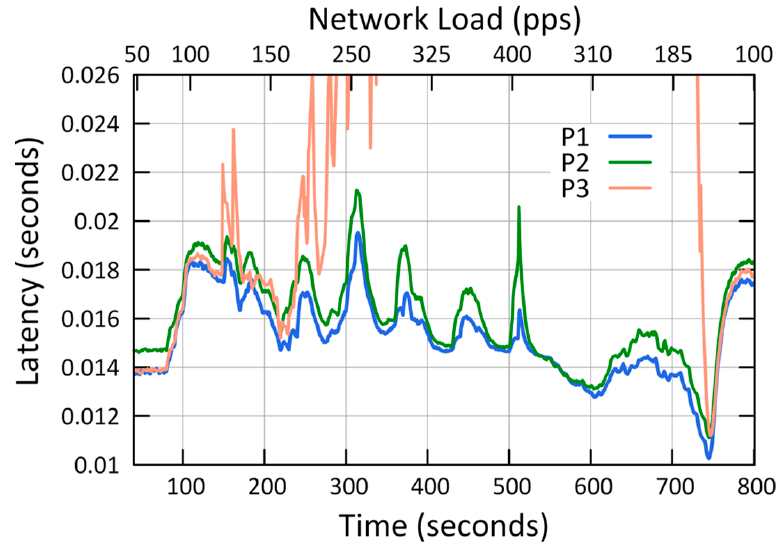
Figure 7. Transmission latency (L) of node 1.